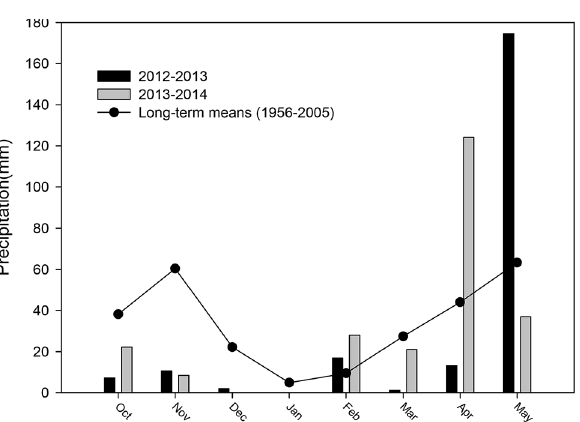
Figure 1. Precipitation during the experimental period (October–May of the following year) between 2012 and 2014 compared with the long-term means (1956–2005) at the experimental